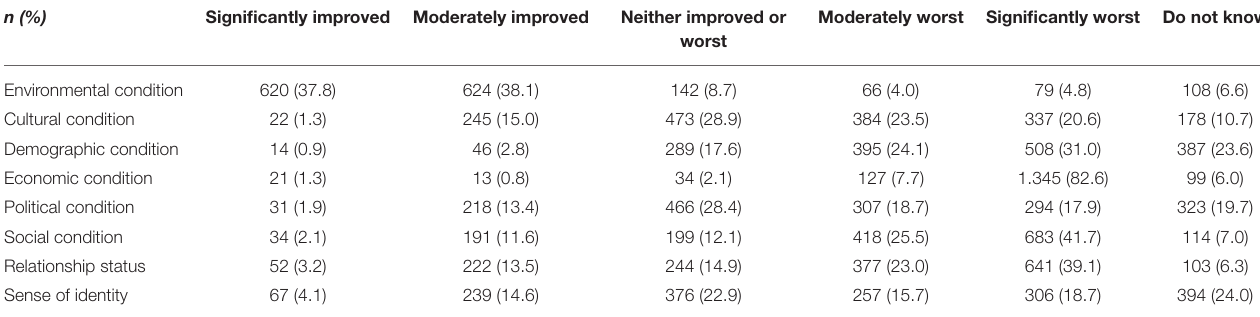
TABLE 3 | Perception of some social conditions by responders during the COVID-19 emergency. n